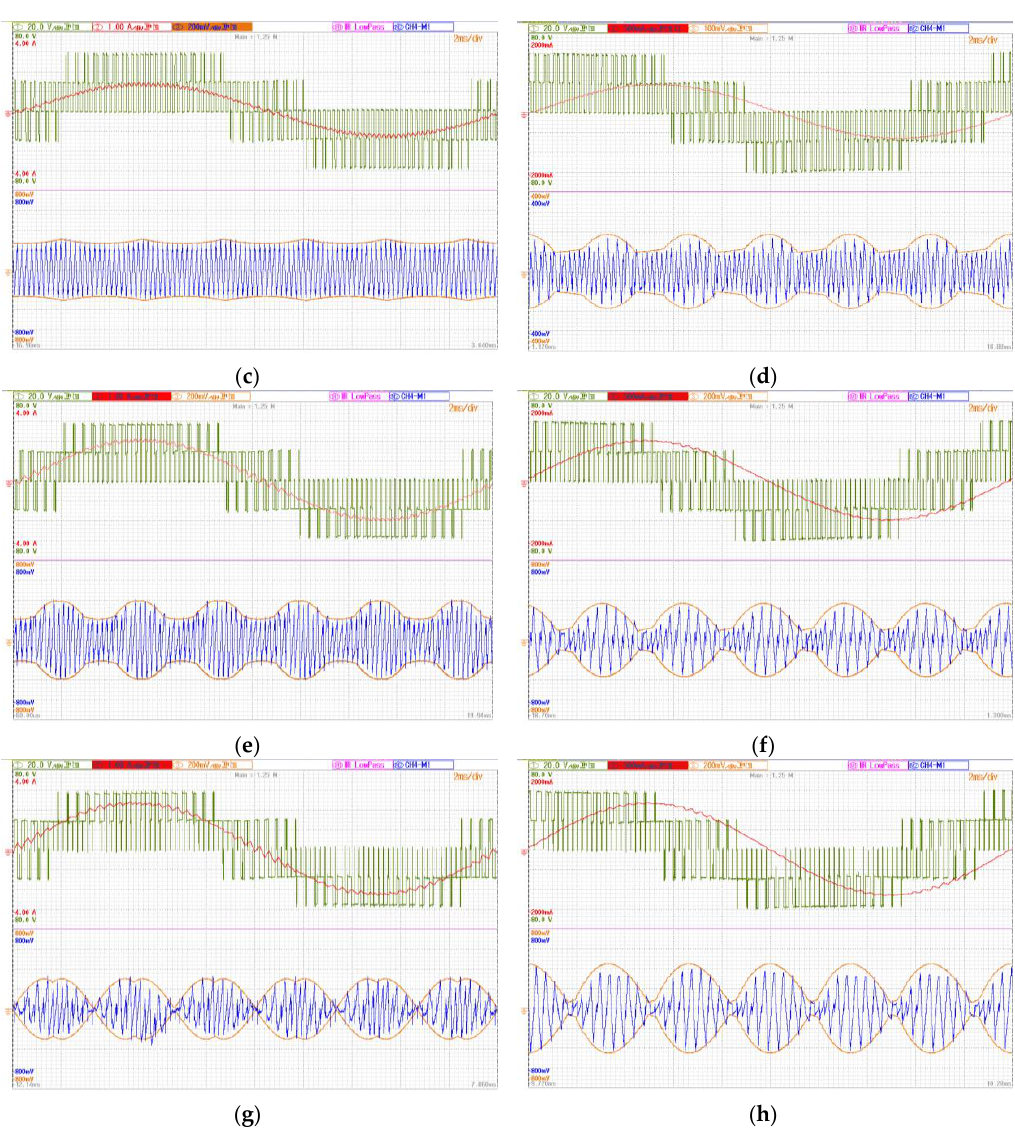
Figure 9. Experimental results for ϕ = 0 ◦ (left) and ϕ = 50 ◦ (right). Upper half: output voltage and current. Lower half: calculated peak-to-peak envelope and measured dc-link voltage switching ripple with different modulation indices: ( a , b ) m = 0.25; ( c , d ) m = 0.33; ( e , f ) m = 0.50; ( g , h ) m = 0.577.